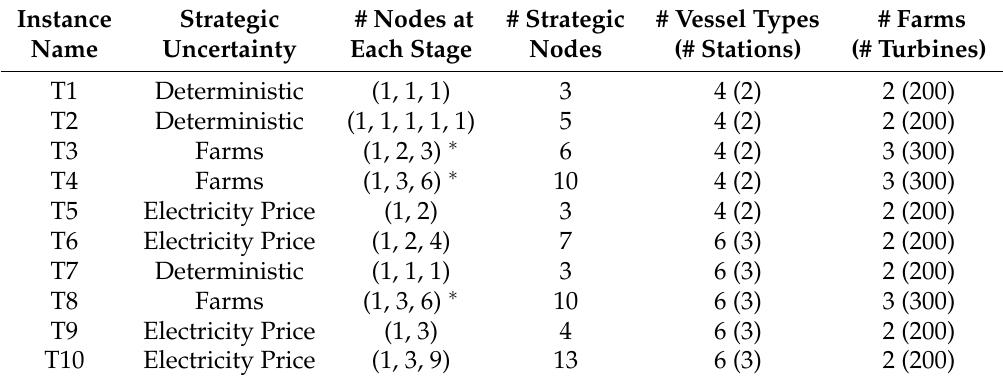
Table 2. Test instances used in the calibration testing of the GRASP. The strategic scenario trees for instances marked with an asterisk are unbalaned. Their structure is explained in